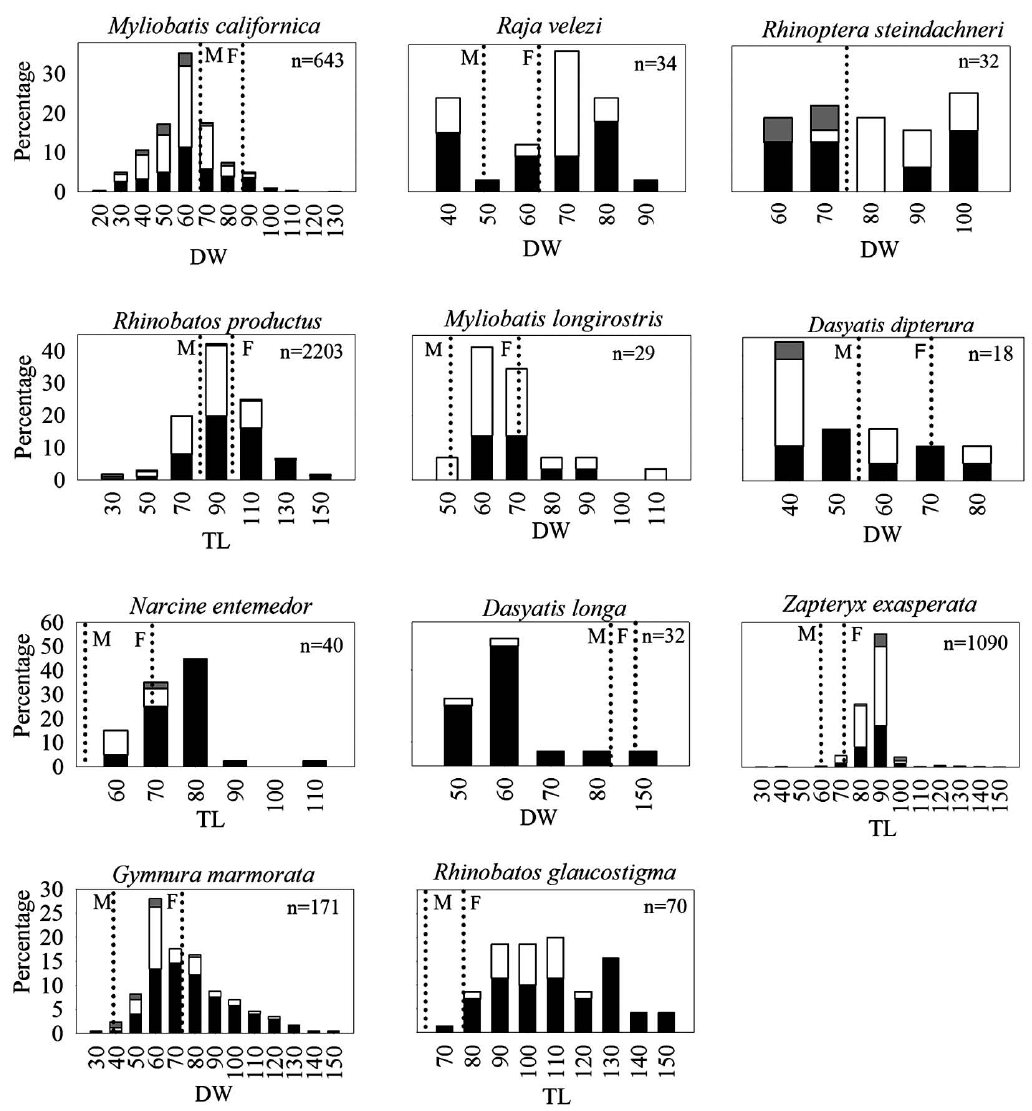
Fig . 3. – Size frequency distributions by sex of batoid species captured by gillnets. n refers to the number of measured individuals. Females are depicted in black, males in white, unsexed specimens in grey. Dotted lines indicate the size at maturity. In cases in which a substantial difference in size at maturity exists between sexes, lines are labeled M (male) or F